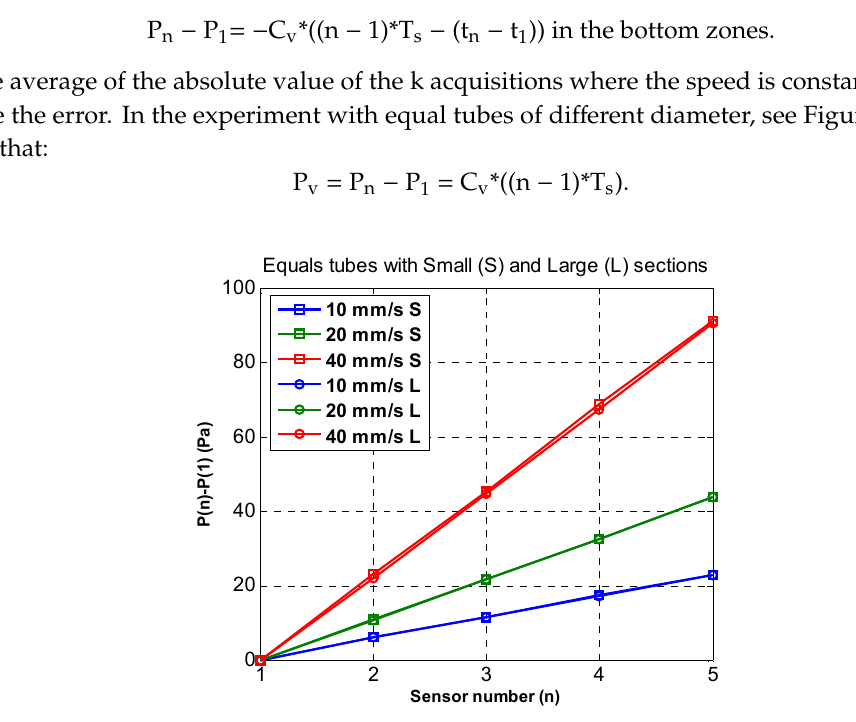
Figure 12. Pressure measurement with respect to the first sensor using equal tubes of different sections (small and large) and different acquisition velocities.